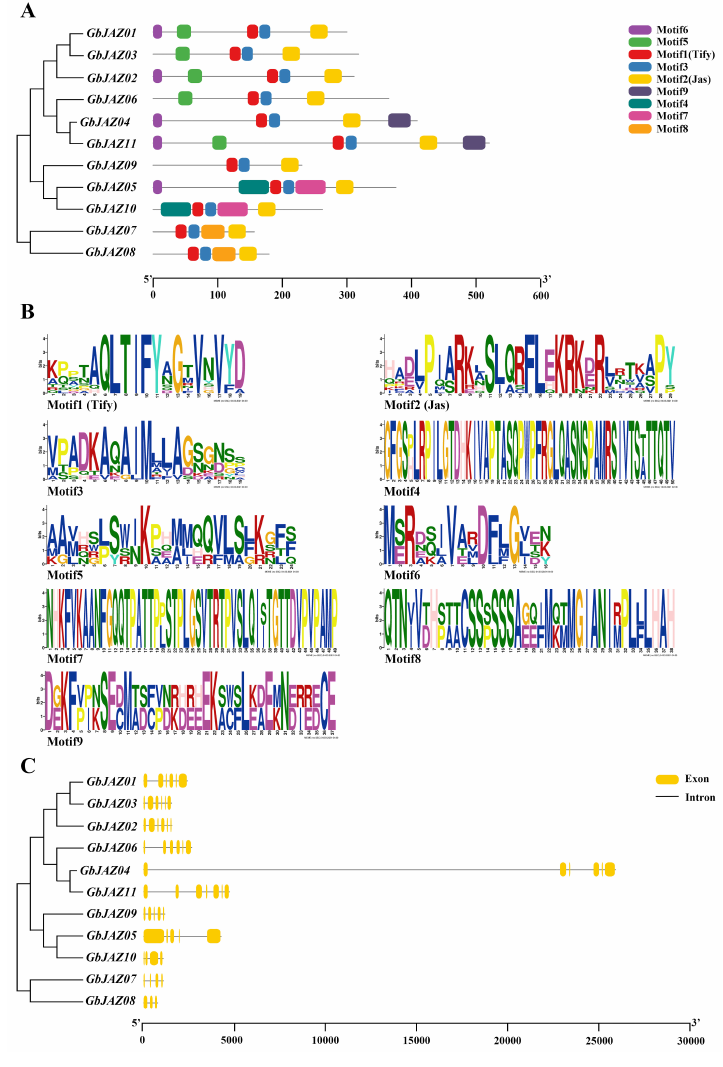
Figure 2. Genetic structure of GbJAZs. ( A ) Evolutionary tree and motif distribution map; ( B ) Motif logo; ( C ) Exon and intron distribution map.